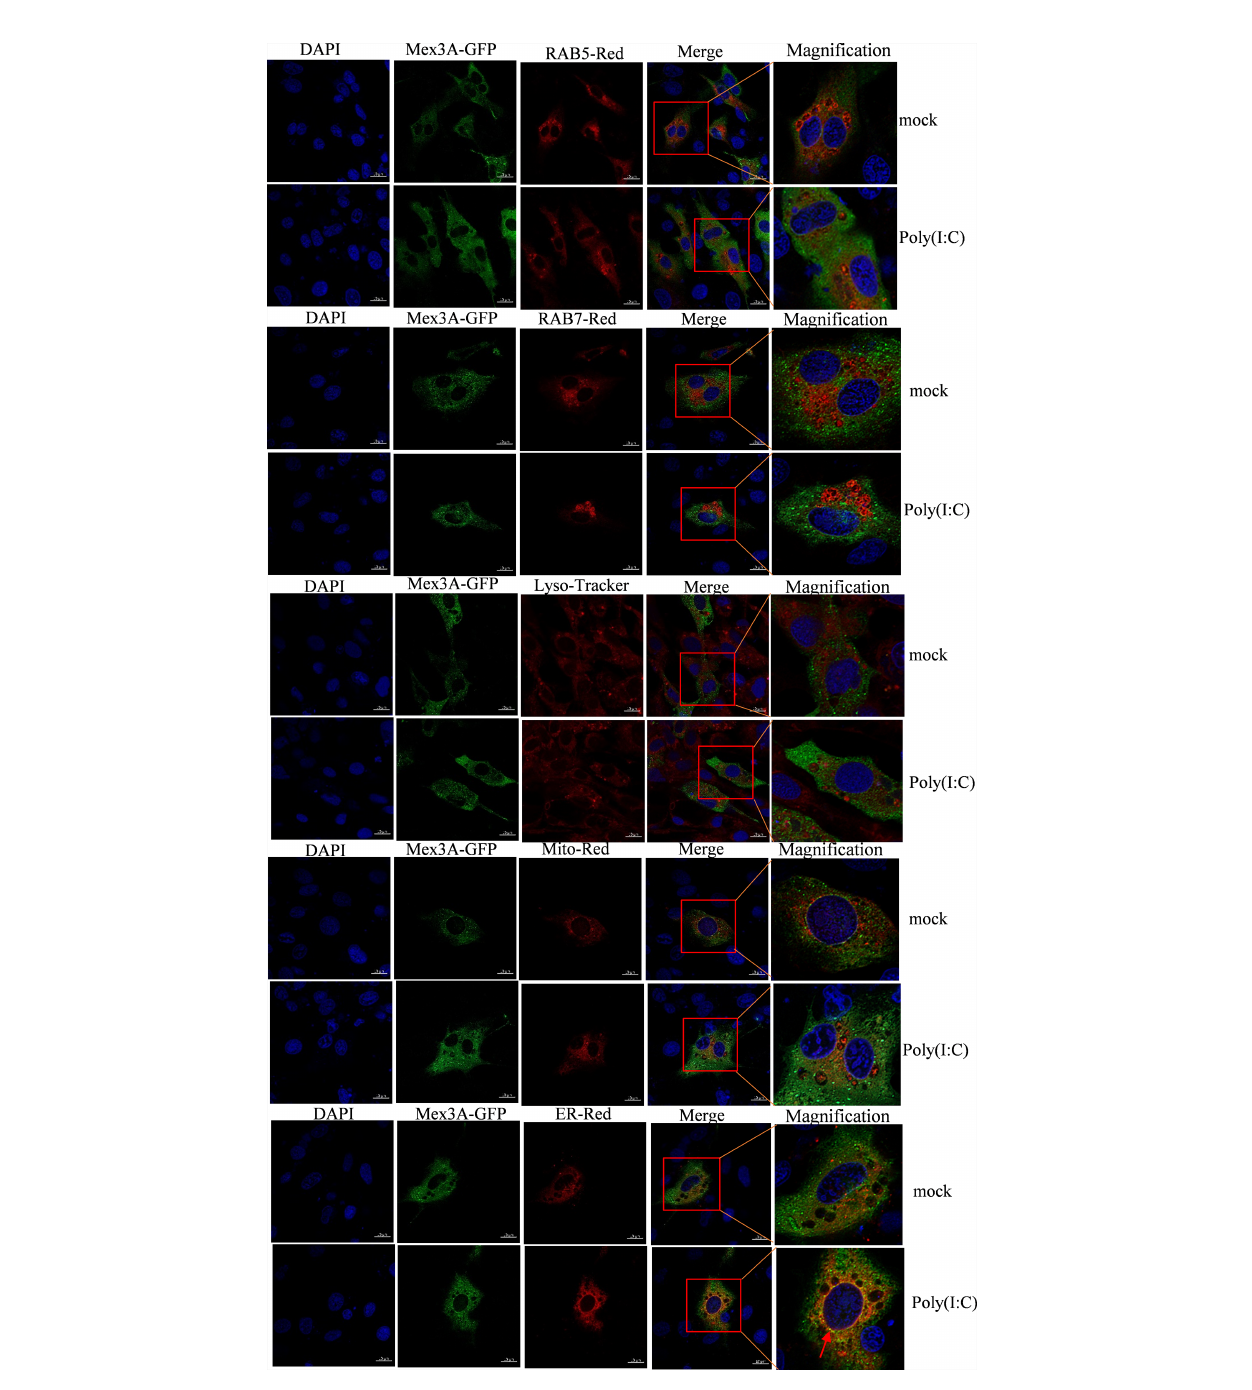
FIGURE 4 | Grass carp Mex3A is located in endoplasmic reticulum. CIK cells were separately co-transfected with 0.5 m g of Mex3A-GFP and 0.5 m g of RAB5-pDsRed2, as well as 0.5 m g of RAB7-pDsRed2, 0.5 m g of Mito-pDsRed2, or 0.5 m g of ER-pDsRed2 plasmids. The photographs were documented using confocal microscopy. In addition, CIK cells were transfected with 1 m g of Mex3A-GFP. At 24 h post transfection, the cells were incubated with Lysosome-Tracker. The bars show 10 m